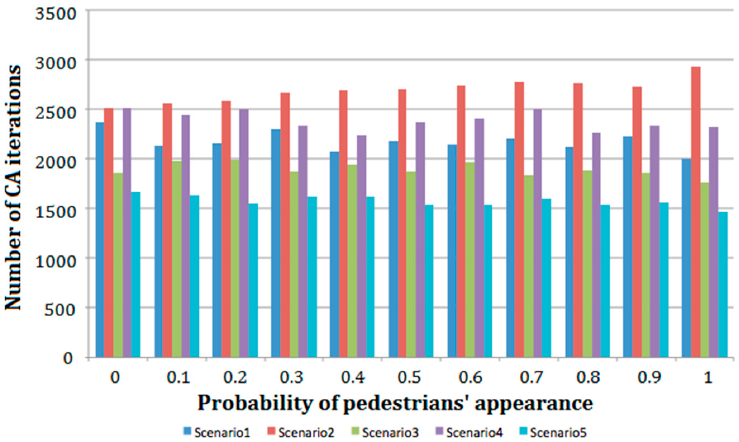
Figure 13. Impact of pedestrian traffic on roundabout capacity as per various traffic scenarios, distance between vehicles = 4. Specified speeds: max car speed = 5, truck speed = 2.